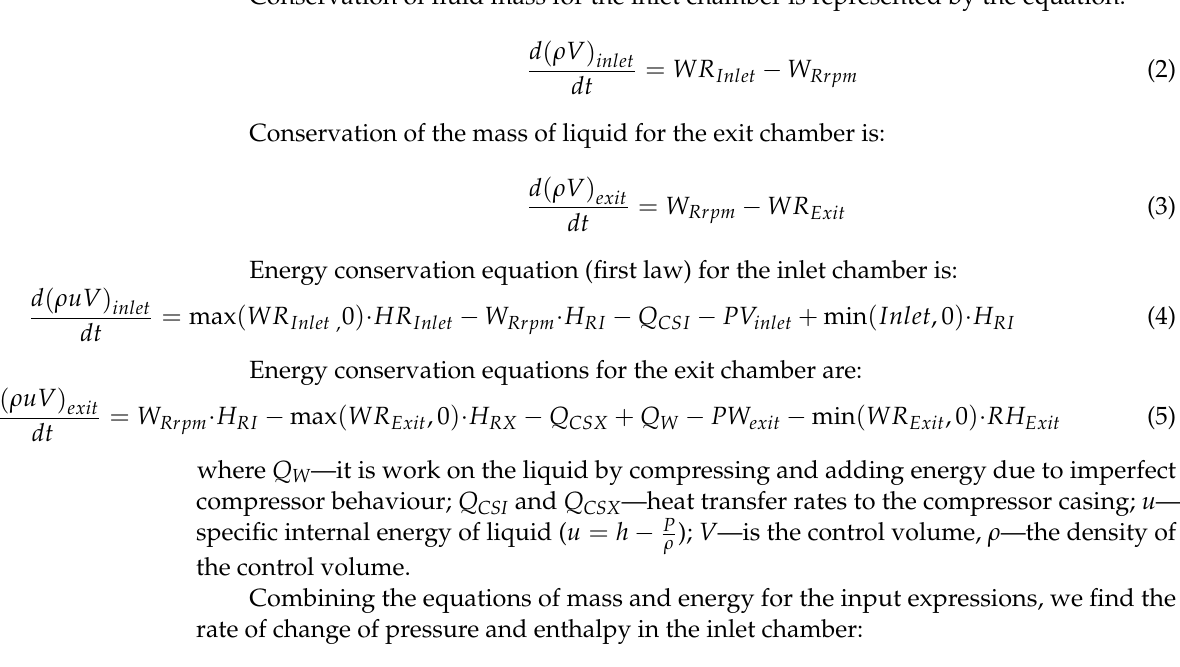
Figure 4. The mathematical model of a compressor block with three inlet and exit ports and N sec- tion.